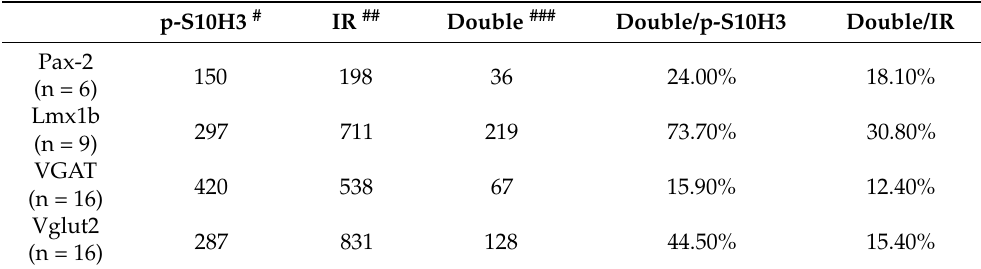
Table 2. Percentage of p-S10H3+ neurons after burn injury that were Pax-2 or Lmx1b-immunoreactive (IR) in wild type mice or that were VGAT- or vesicular glutamate transporter 2 (Vglut2)-IR in VGAT- or Vglut2:tdTomato transgenic